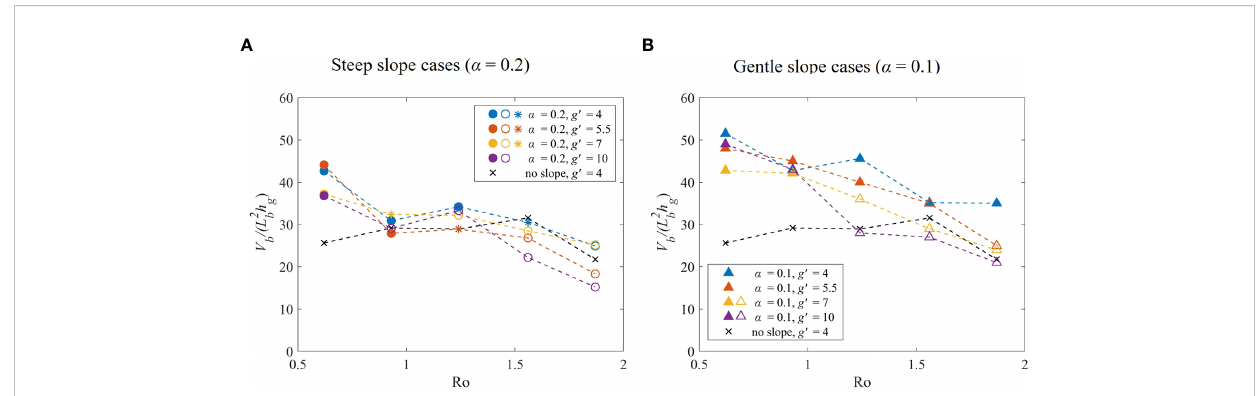
FIGURE 10 Normalized mean bulge volume in stationary phase (8 – 9 T ). Circle and triangle symbols represent steep ( a = 0.2) and gentle slope ( a = 0.1) cases, respectively. The solid, asterisk and hollow symbols represent bottom-attached, transitional and surface-advected plumes, respectively. Black dash lines with cross symbols are the no-slope case for comparison. The dash line represents the trend of V_b/(L_b^2h_g) changing with